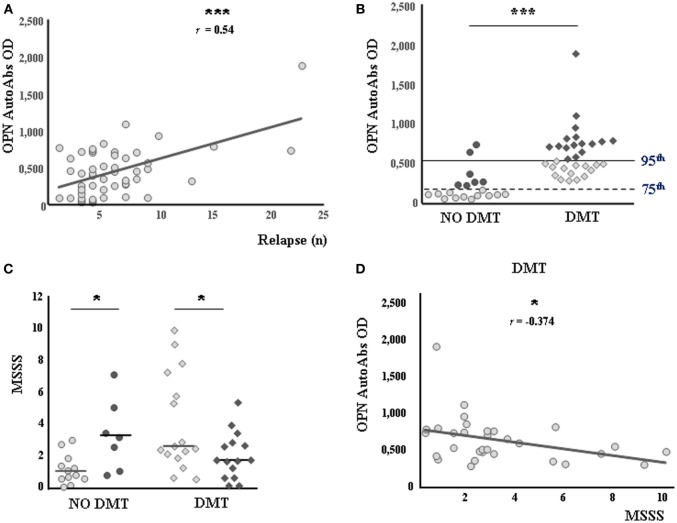
Autoantibodies (autoAbs) to osteopontin (OPN) at diagnosis predict therapeutic benefits and a reduced Multiple Sclerosis Severity Score (MSSS). (A) Direct correlation between anti-OPN autoAbs and the number of relapses occurring over 10 years (Pearson correlation test). (B) Anti-OPN autoAbs in patients not receiving (circles) or receiving (diamonds) disease-modifying treatments (DMTs). The horizontal lines indicate the 75th (dashed line) and 95th (continuous line) percentiles of the healthy controls. Low expressors and high expressors of each group are shown in pale color and in dark color, respectively. (C) MSSS in patients with or without DMTs. Low expressors are shown in pale color; high expressors are shown in dark color, as in the previous panel. (D) Negative correlation between autoAbs to OPN and the MSSS in the treated group (Pearson correlation test) (*p < 0.05, ***p < 0.0001).